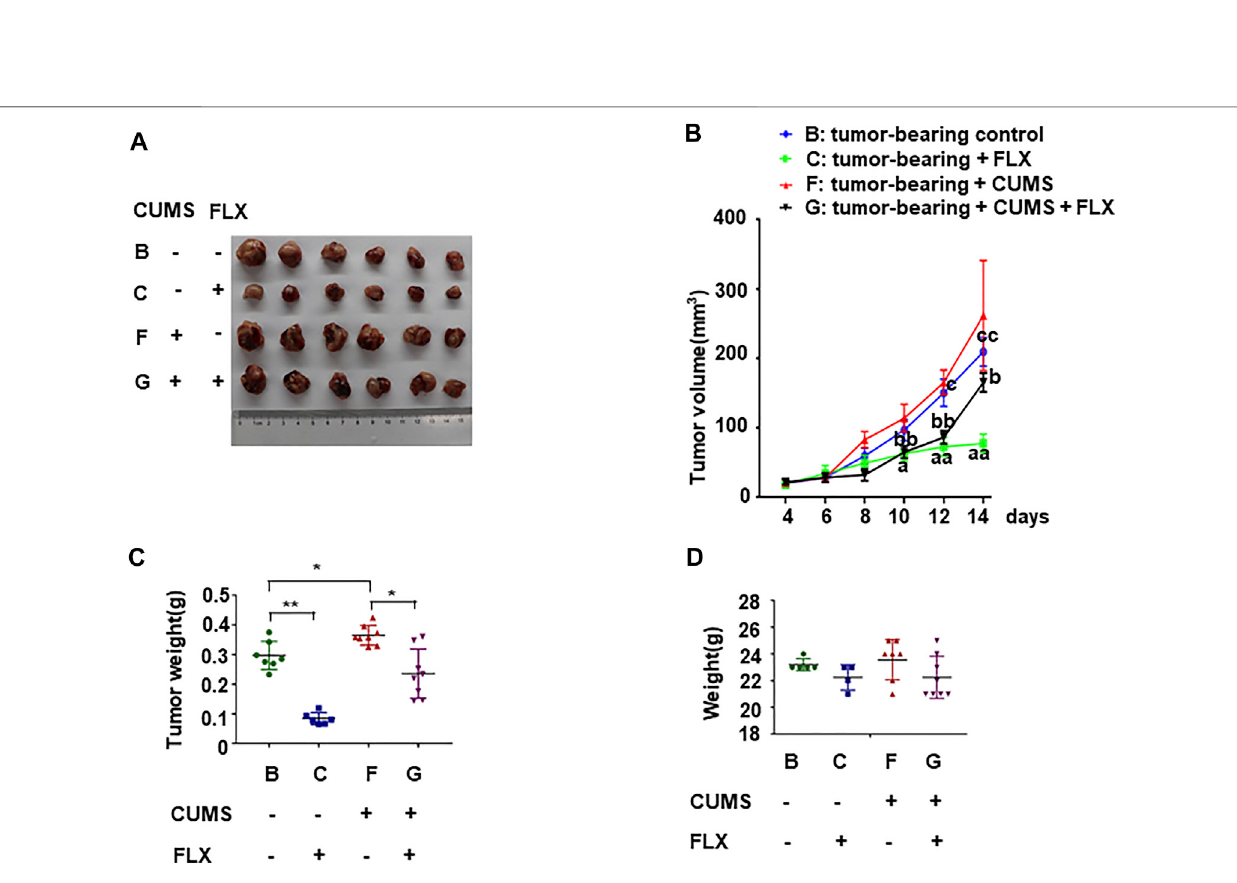
Frontiers in Pharmacology |